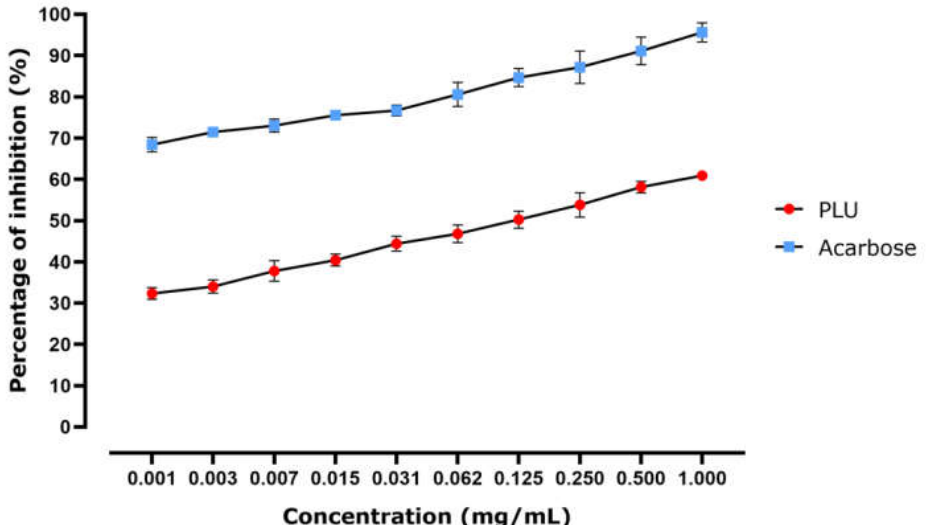
Figure 5. In vitro α -glucosidase inhibitory activity in response to PLU and acarbose represented as percentage of inhibition of the enzyme activity.